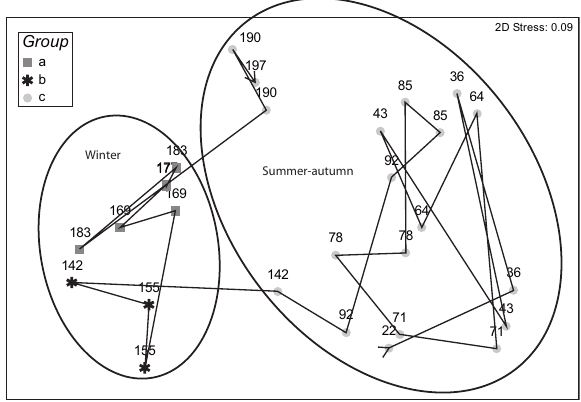
Fig . 9. – MdS (2-d minimum stress: 0.09) result of abiotic data. the black arrow shows the time sequence of sampling. cluster and season groups are also